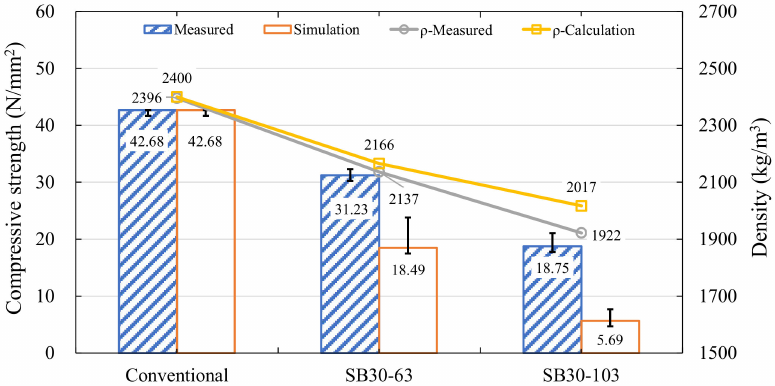
Figure 11. The density and compressive strength of 2009 SB concrete.